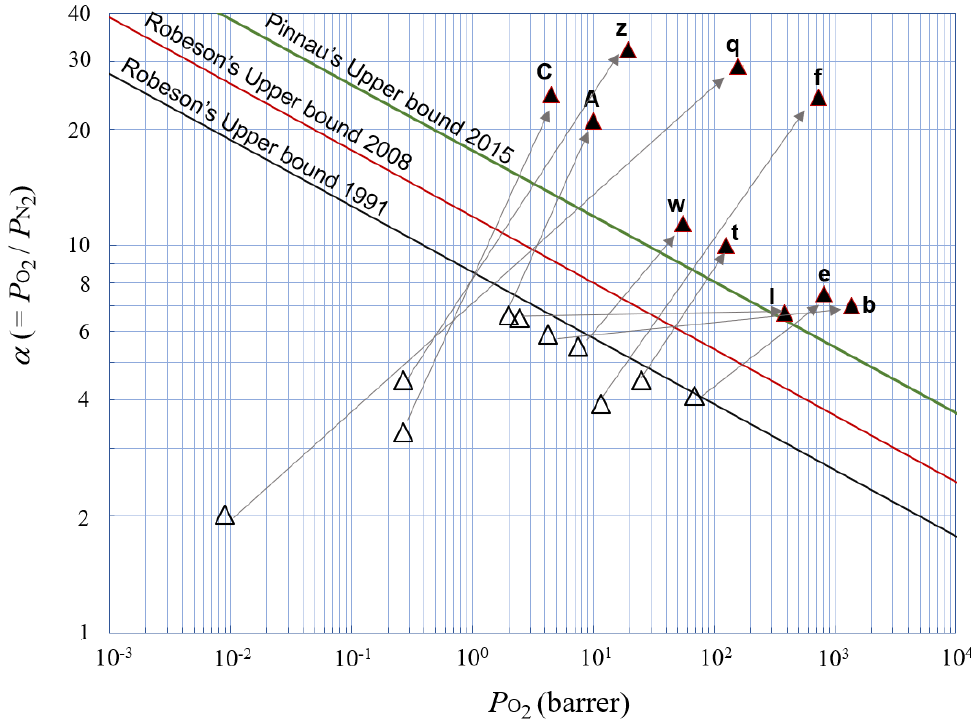
Figure 11. Change in the α and P O 2 from the precursor polymers to carbon molecular sieve membranes (CMSMs). For the codes, data and categorization of the precursor polymers of the plots, see Chart 7.